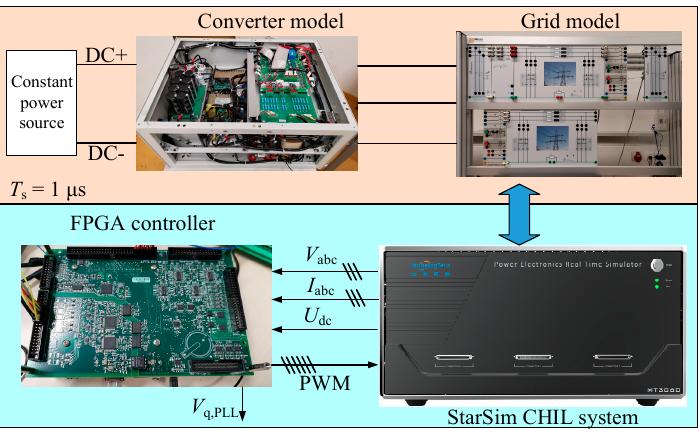
Figure 10. CHIL experimental